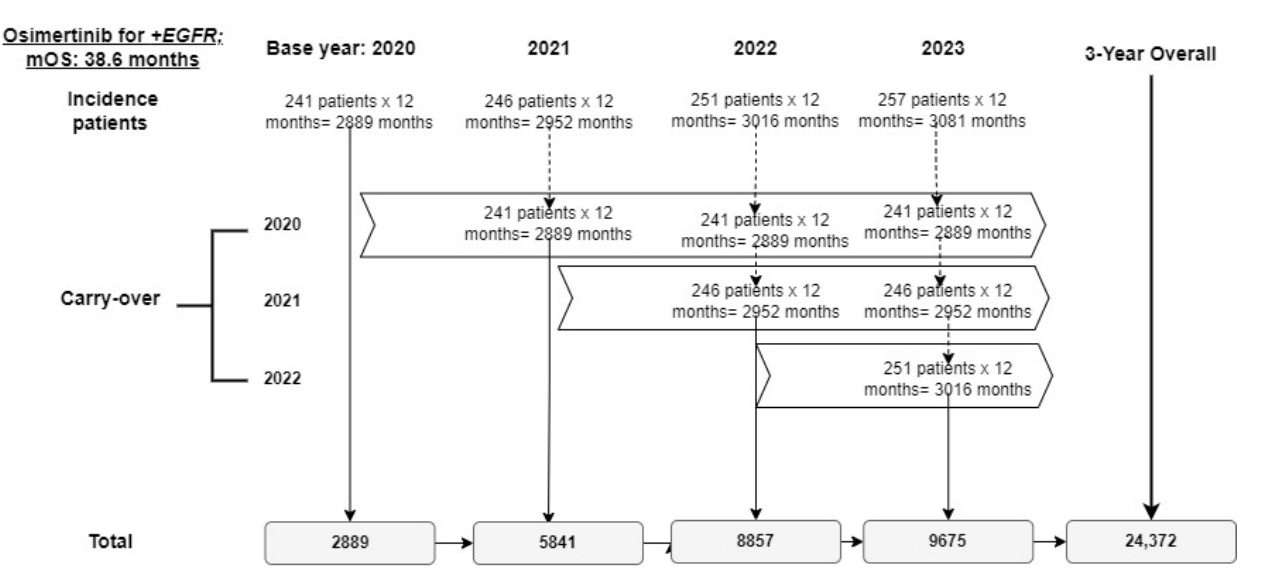
Figure 5. Health impact sample calculation. Table 4. Health outcomes data.